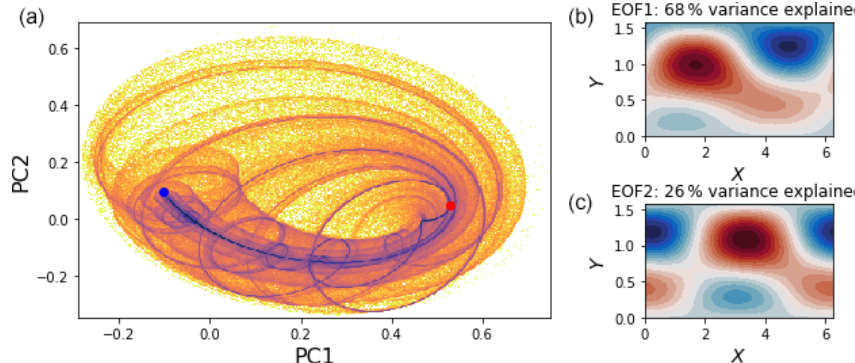
Figure 1. (a) Projection of the deterministic attractor into the space of the leading EOFs, capturing 92% of the total variance. (b, c) The flow patterns corresponding to the first and second EOFs of the system. Blue and red dots show the positions of fixed points corresponding to blocked and zonal flows respectively.